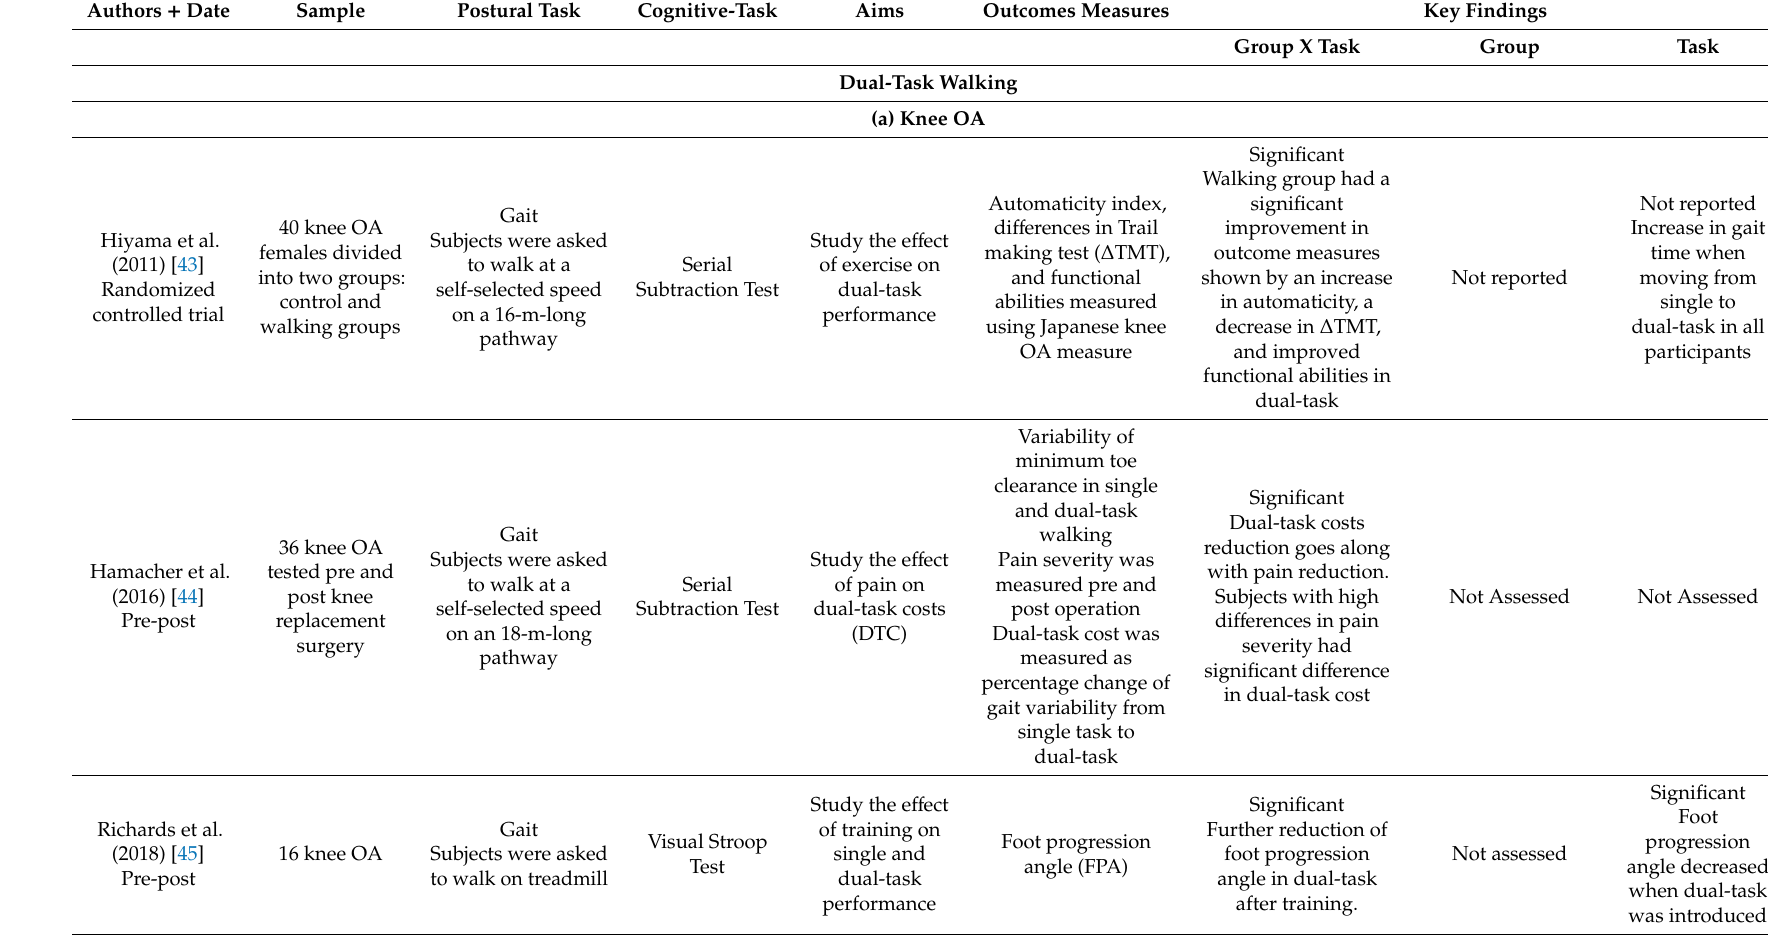
Table 2. Studies included in this review dealing with dual-task during